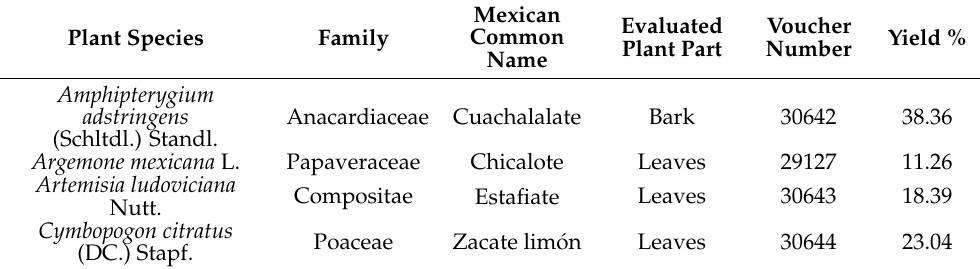
Table 1. Plants used in this study and percentage of extraction